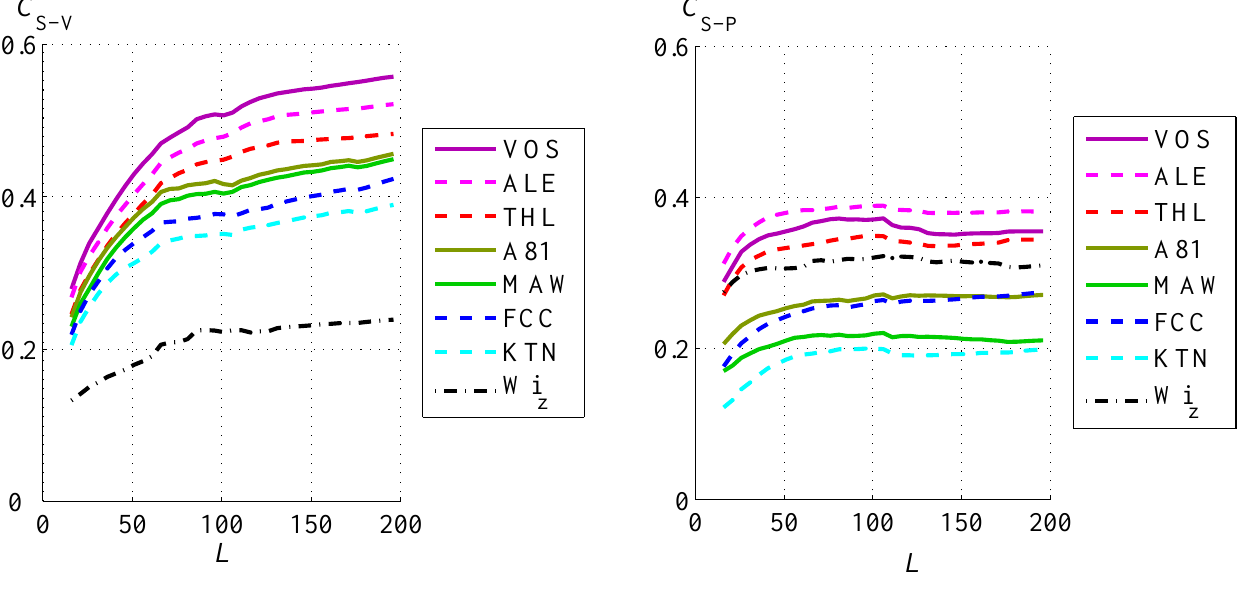
Fig. 3. The same as Fig. 2, but for the correlation between S and the SW dynamic pressure P